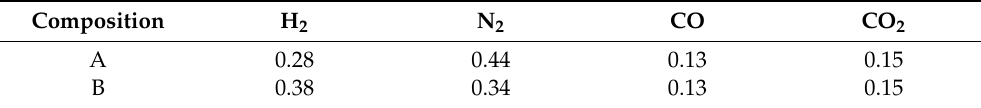
Table 2. Inlet gas